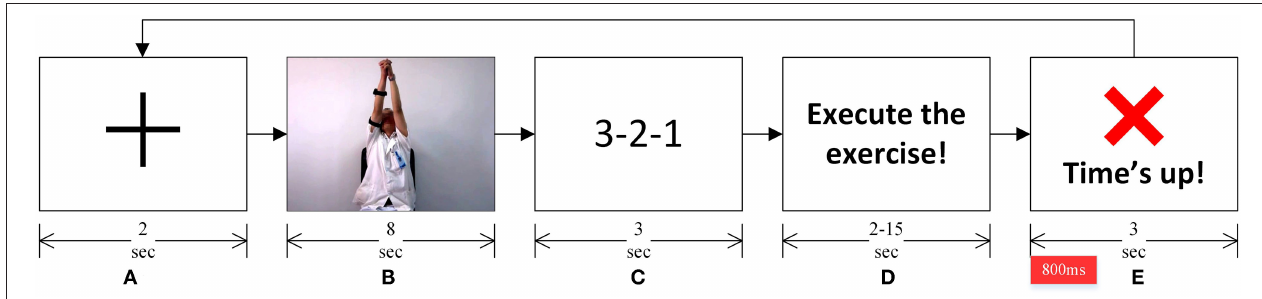
FIGURE 3 | (A) A fixation cross marked the start of a trial. (B) A pre-recorded video showed the rehabilitation exercise to be performed. (C) A 3-2-1 timer. (D) Instruction to the participants to start performing the rehabilitation exercise depicted in the video. (E) Participants were asked to complete the rehabilitation exercise before this “Time’s up!” screen appeared. This marked the completion of one exercise trial, and subsequently, the next trial started with the fixation cross. The epoch of interest for EEG analyses is marked in red on the timeline, immediately after the “Time’s up!” screen